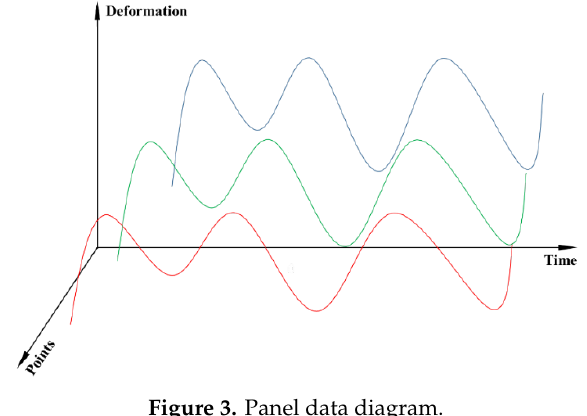
Figure 3. Panel data diagram.